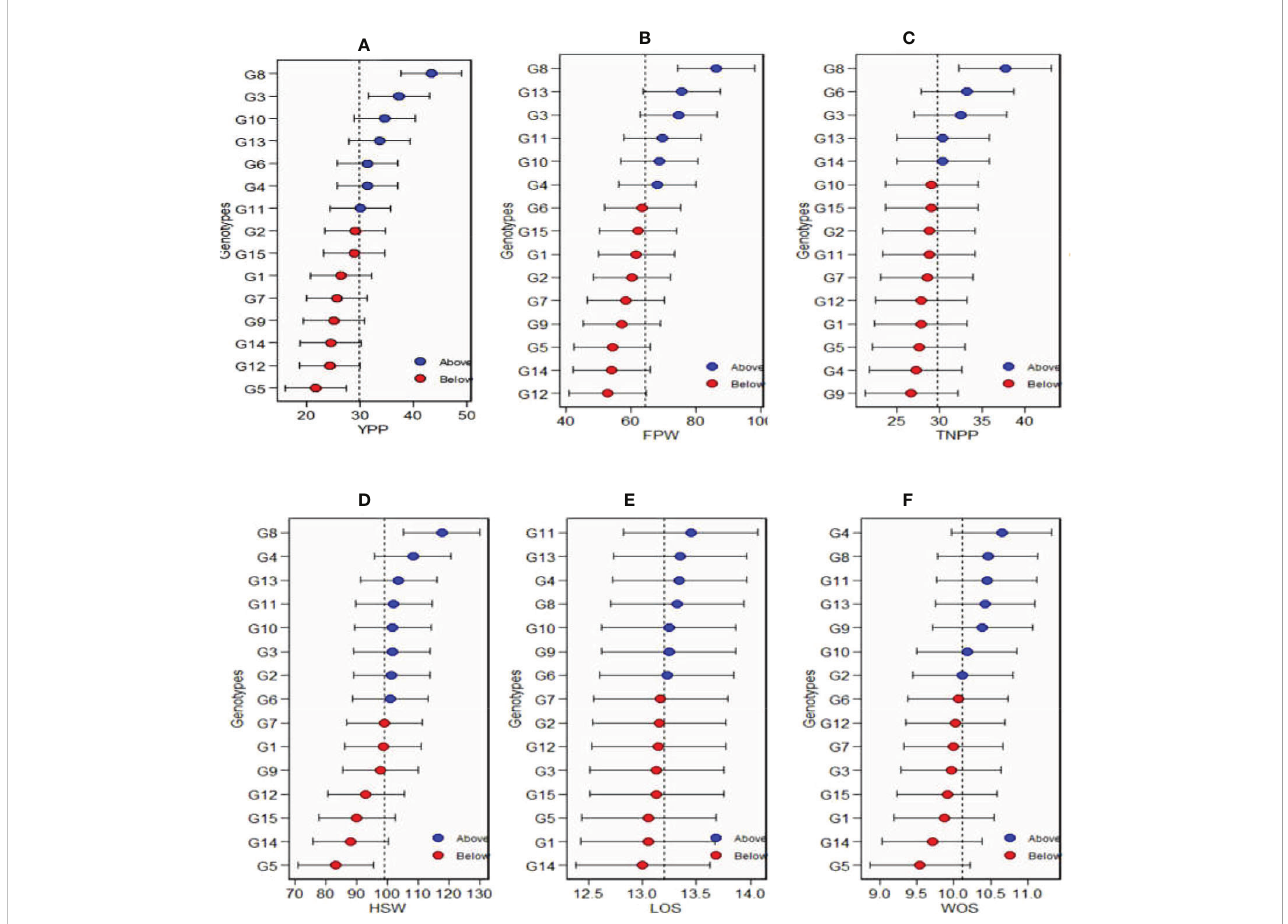
FIGURE 6 Estimated values of average of the stability and mean performance for 15 Bambara groundnut genotypes: (A) yield per plant (YPP), (B) fresh pod weight (FPW), (C) total no. of pods per plant (TNPP), (D) hundred seed weight (HSW), (E) length of seeds (LOS), and (F) width of seeds